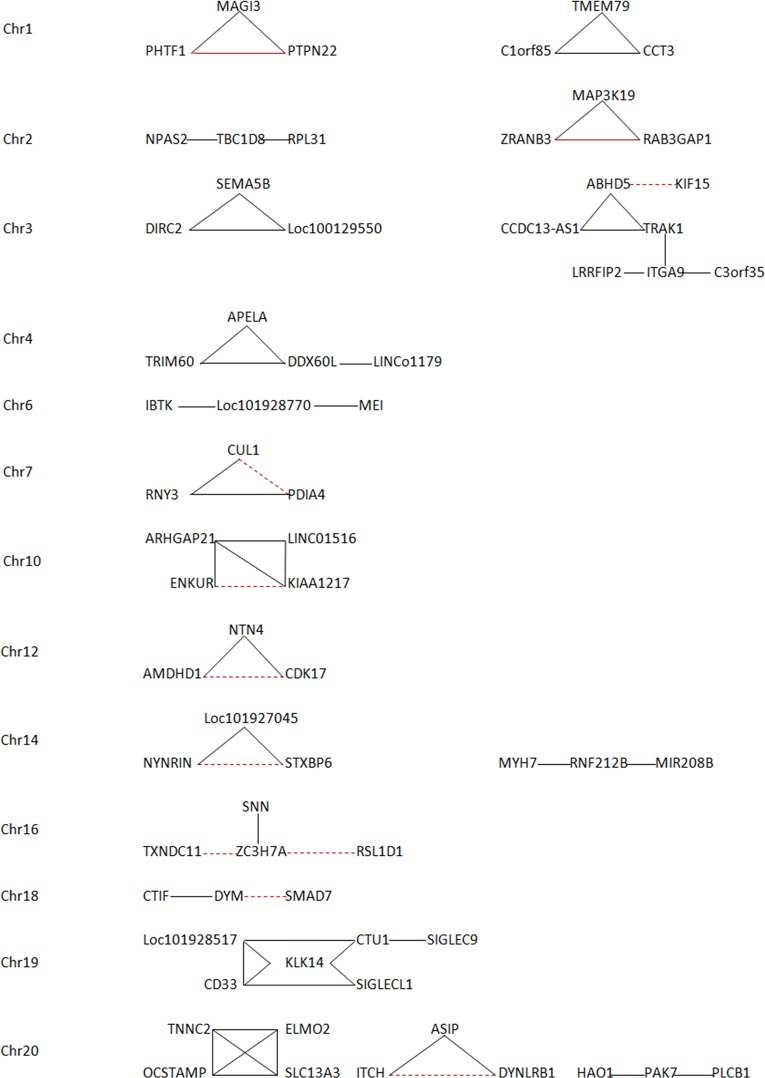
Nineteen networks of the interactions among three or more genes detected from the significant difference between the composite digenic and maximum zygotic LDs.The dashed red lines refer to the presence of a common interactor connecting two interacted genes from the information at http://thebiogrid.org/121402/summary/homo-sapiens/. The solid red lines refer to the presence of direct evidence from empirical studies.